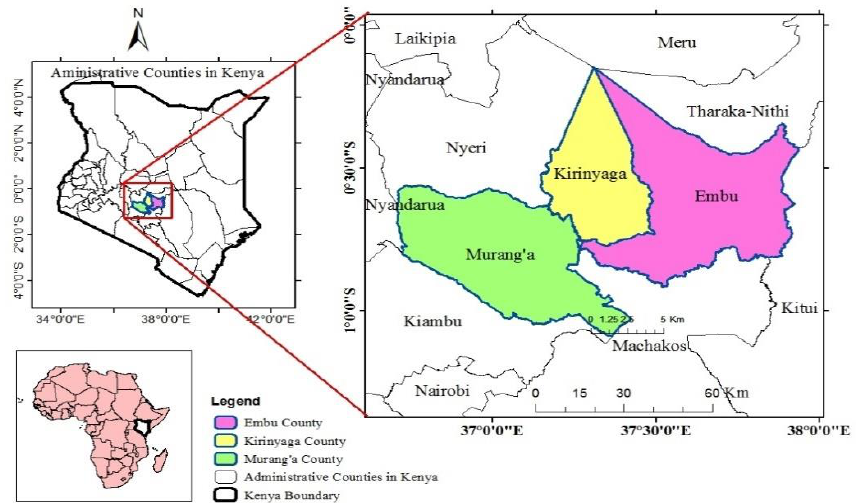
Figure 1. Map of the study area. Source: Authors’ survey, 2017.